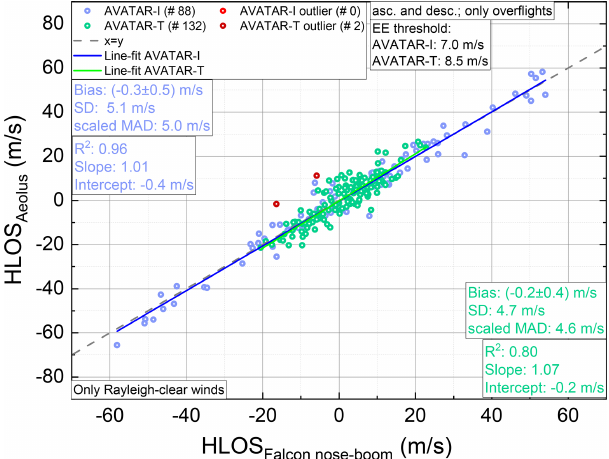
Figure 6. Aeolus Rayleigh-clear HLOS winds plotted against the Falcon nose boom wind speed projected onto the horizontal view- ing direction of Aeolus for the 10 underflights performed during the AVATAR-I campaign (blue) and for the 11 underflights performed during the AVATAR-T campaign (green). Outliers that exceeded a modified Z -score threshold of 3 are indicated by light red and dark red points, respectively. Corresponding least-square line fits are in- dicated by the dark blue and light green line, respectively. The fit results are shown in the insets. The x = y -line is represented by the gray dashed